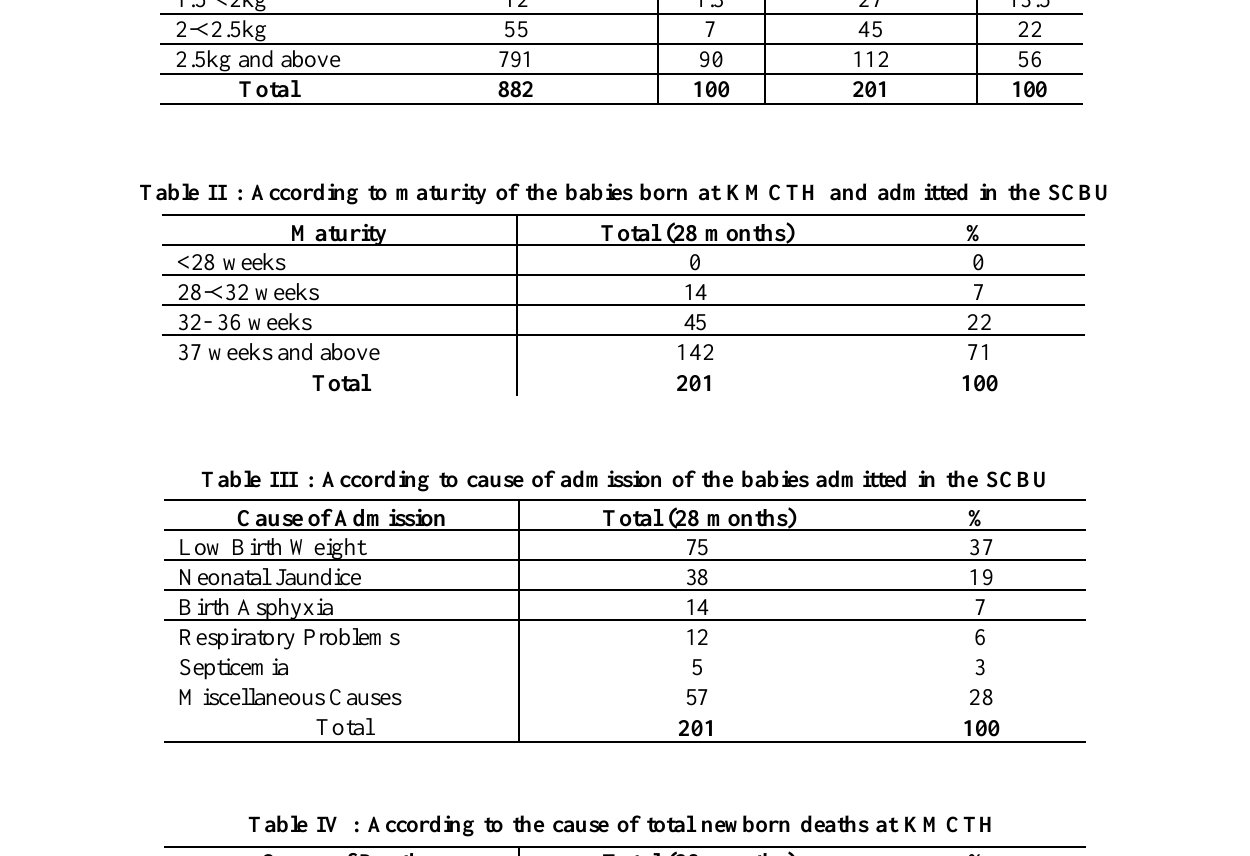
Table IV : According to the cause of total newborn deaths at KMCTH Cause of Death Extreme Prematurity